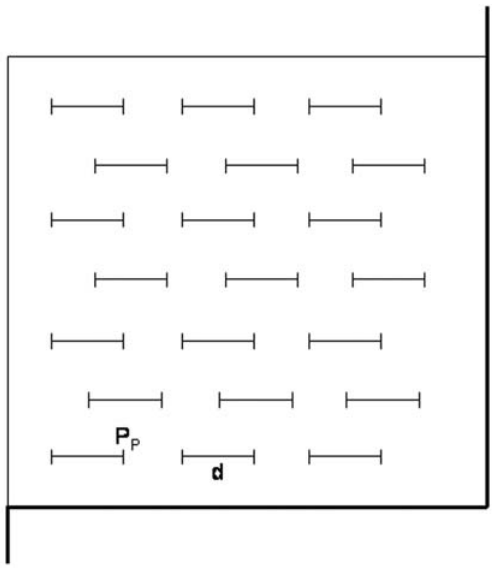
Fig. 10 – M42 test-system. This system has 21 short lines with known length (d) and two test-points in each extremity (P P , 42 test-points in total). The test-area is 36.36d 2 . The thicker lines are ‘‘forbidden’’ (see explanation in Figure 13).